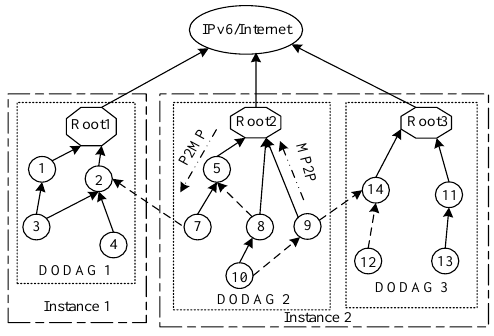
Figure 1. RPL Figure 1. RPL Network.